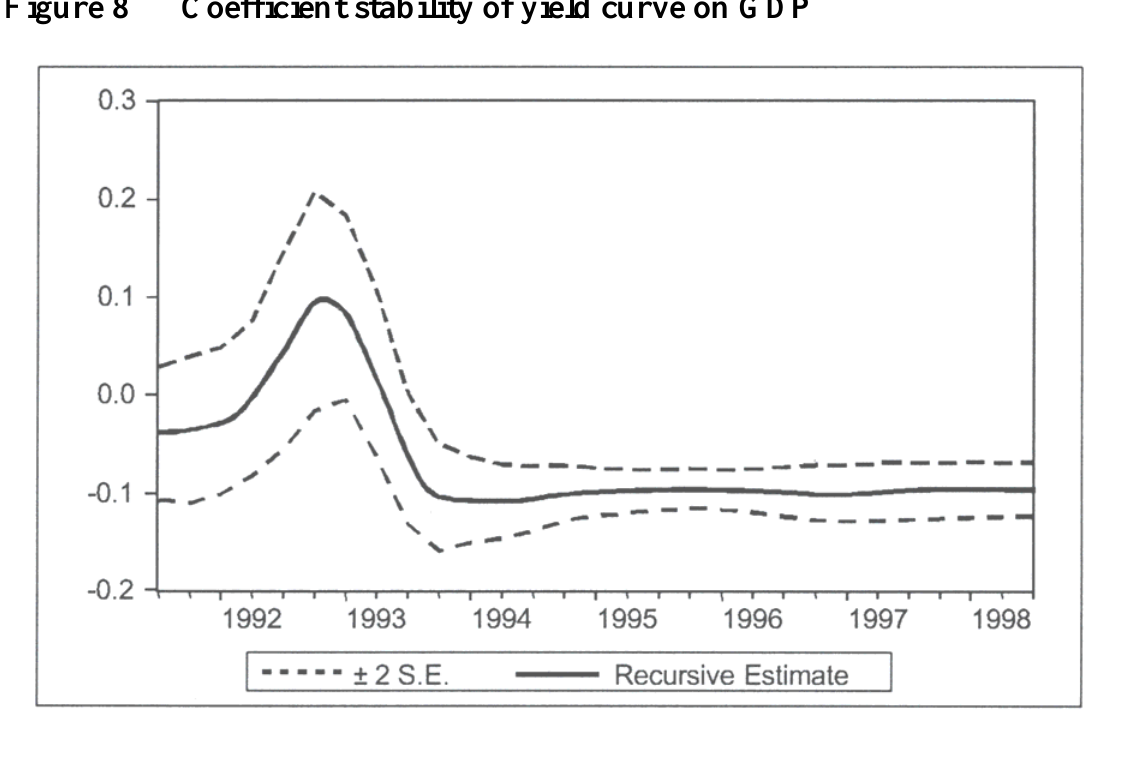
Coefficient stability of yield curve on